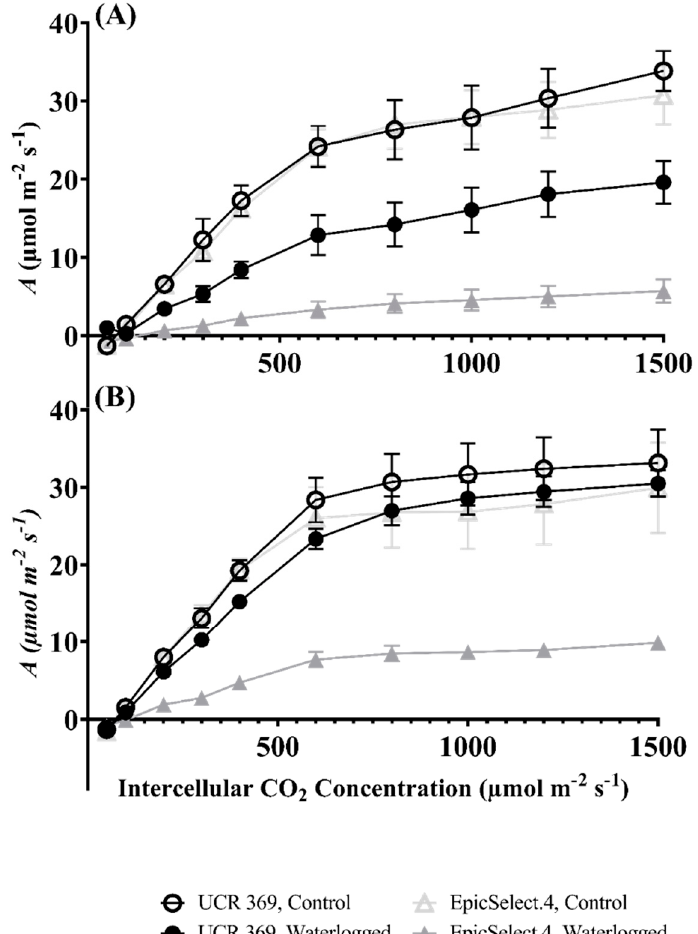
Figure 2. ( A ) Response of the CO 2 assimilation rate ( A ) to increasing intercellular CO 2 concentration (C i ) ( A /C i Curve) in the two cowpea genotypes (UCR 369 and EpicSelect.4) after 7 days of control and waterlogging treatments; ( B ) A /C i Curve in the two cowpea genotypes (UCR 369 and EpicSelect.4) after 7 days of recovery. The vertical bars represent the standard error of the mean (n = 5). We used the A /C i data of cowpea genotypes displayed in Figure 2 to estimate the mesophyll g m , V cmax , and J max at both 7 DOW and 7 DOR. Waterlogging significantly af-